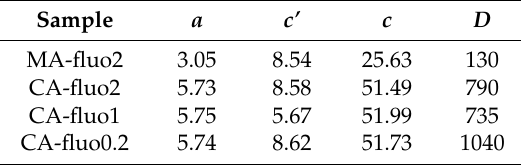
Table 2. Lattice parameters (Å) and average crystallite size ( D , Å) of the synthesised